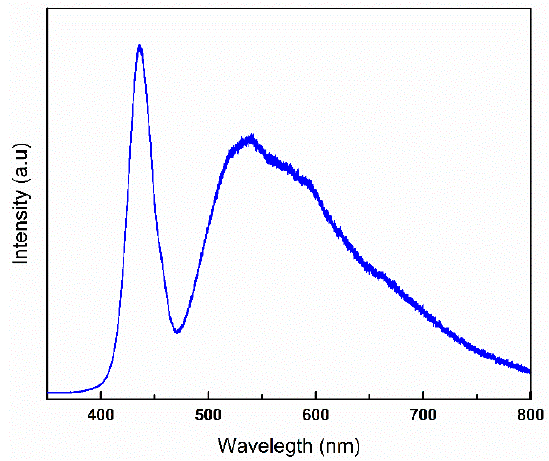
Figure 9. Photoluminescence spectra of synthesised ZnO nanoparticles.